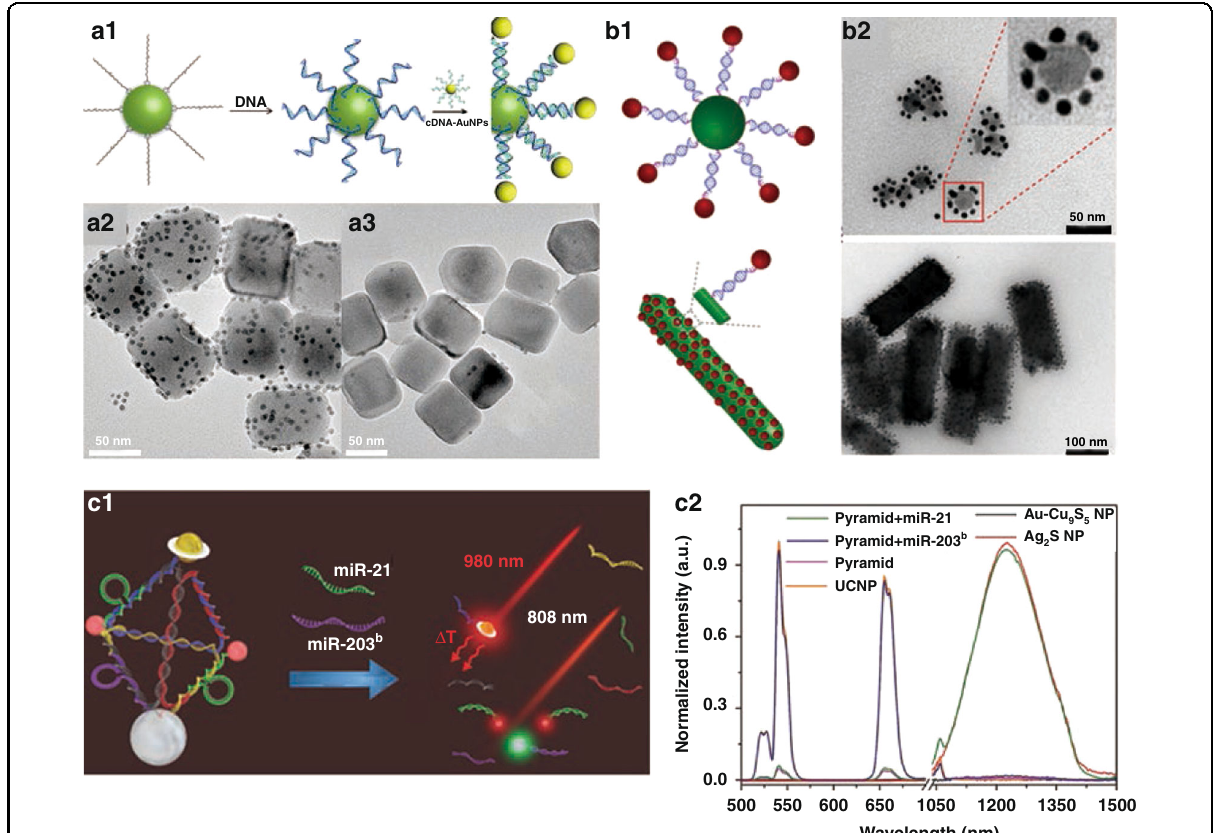
Fig. 3 Speci fi c recognition reaction. a1 Schematic illustration of DNA-directed assembly of UCNPs and AuNPs. TEM images of the assembly of T30- UCNPs with AuNPs containing complementary DNA ( a2 ) and non-complementary DNA ( a3 ) 32 . b1 Schematic illustrations of the DNA-mediated assemblies of UCNPs and AuNPs (5 nm). b2 TEM images of DNA-mediated assemblies UCNPs (NaYF 4 :Yb/Er nanospheres and NaYF 4 :Gd/Yb/Er nanorods) with AuNPs 33 . c1 Nanopyramids for dual miRs detection. c2 Luminescence spectra of Ag 2 S NPs, Au-Cu 9 S 5 NPs, UCNPs, pyramids, pyramids with miR-21, and pyramids with miR-203 b excited by 808 nm laser 34 . a1 – a3 Reprinted with permission from ref. 32 Copyright 2013,